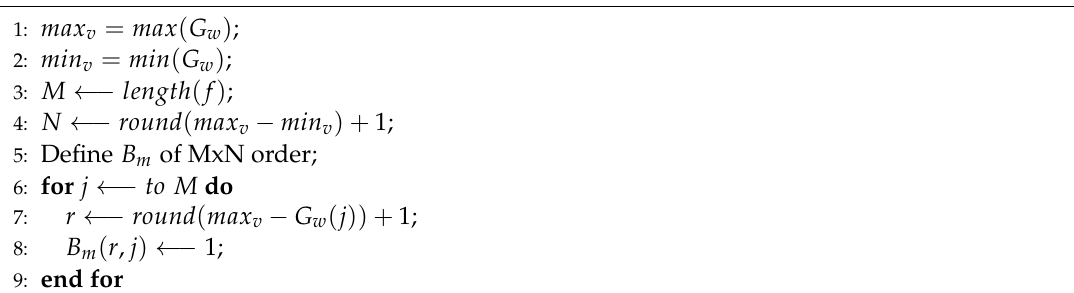
Algorithm 1 Generate geomagnetic pattern